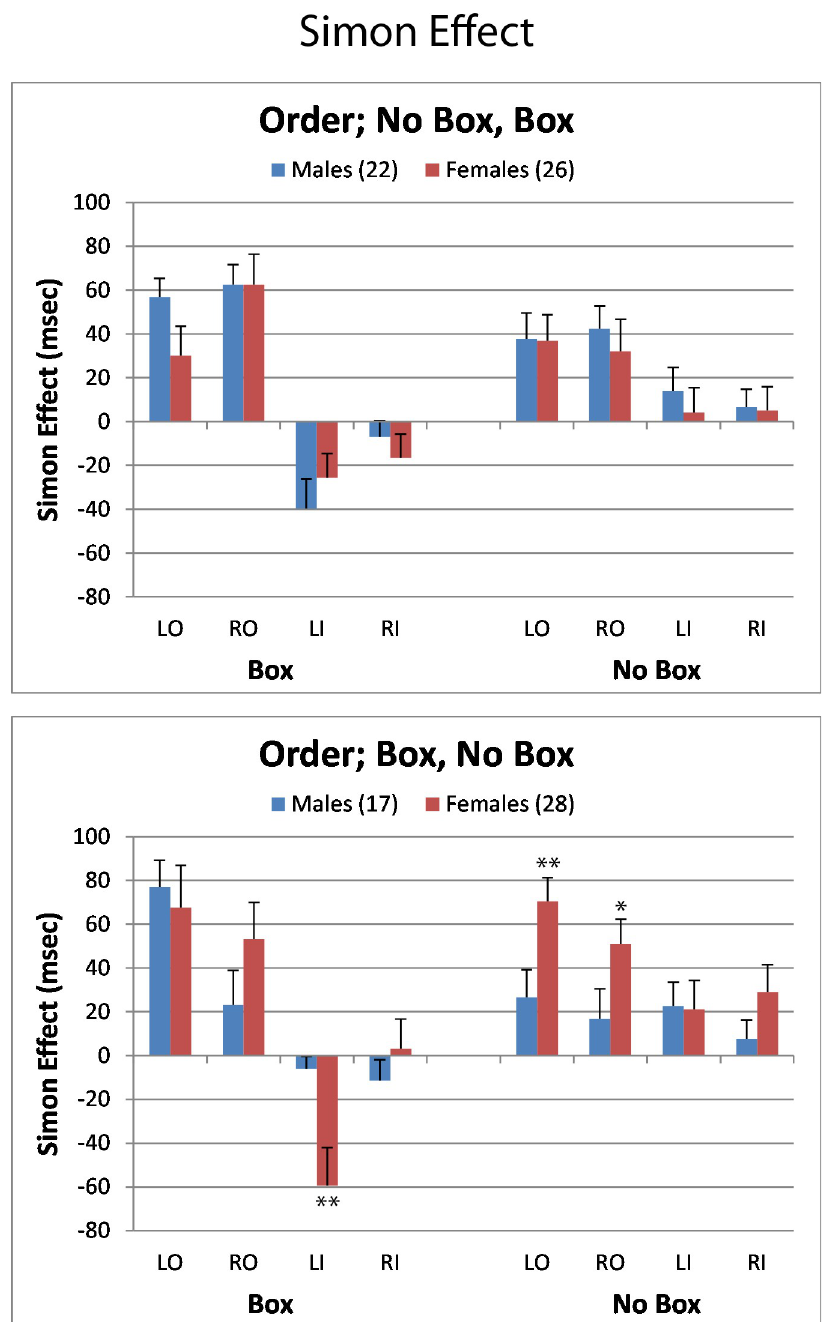
Fig 3. Simon effect is depicted as the mean difference in RT for the incongruent minus the congruent stimulus. Post hoc sex differences for individual conditions are identified by � (p < 0.05) or �� (p <